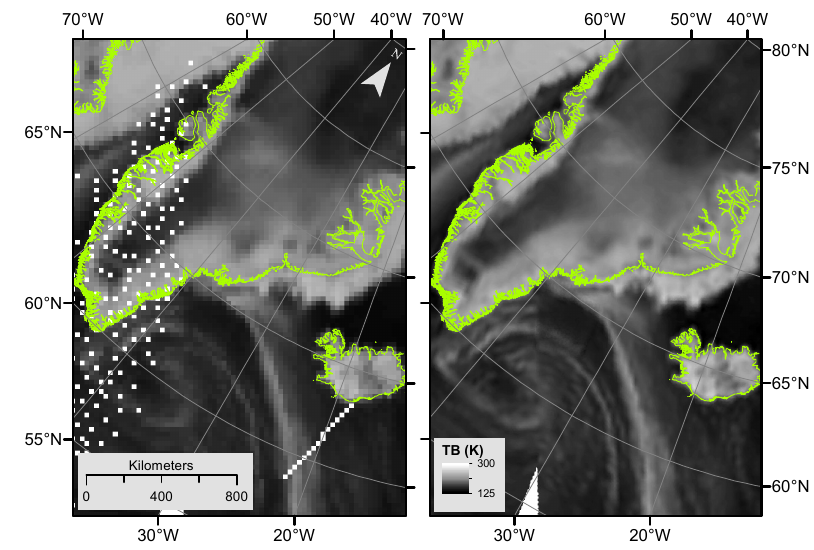
Figure 4. CETB DMSP-F13 SSM/I 37 GHz horizontally-polarized evening overpass brightness temperatures, 5 January 2003, demonstrating rSIR resolution enhancement at 3.125 km ( right ) compared to conventional 25 km spatial resolution ( left ). White pixels are locations where no swath measurement location was mapped to the target pixel location. GeoTIFFs are derived by gdal_translate , read and zoomed in ArcMap to North Atlantic and easily overlaid with coastlines [39] with no special steps